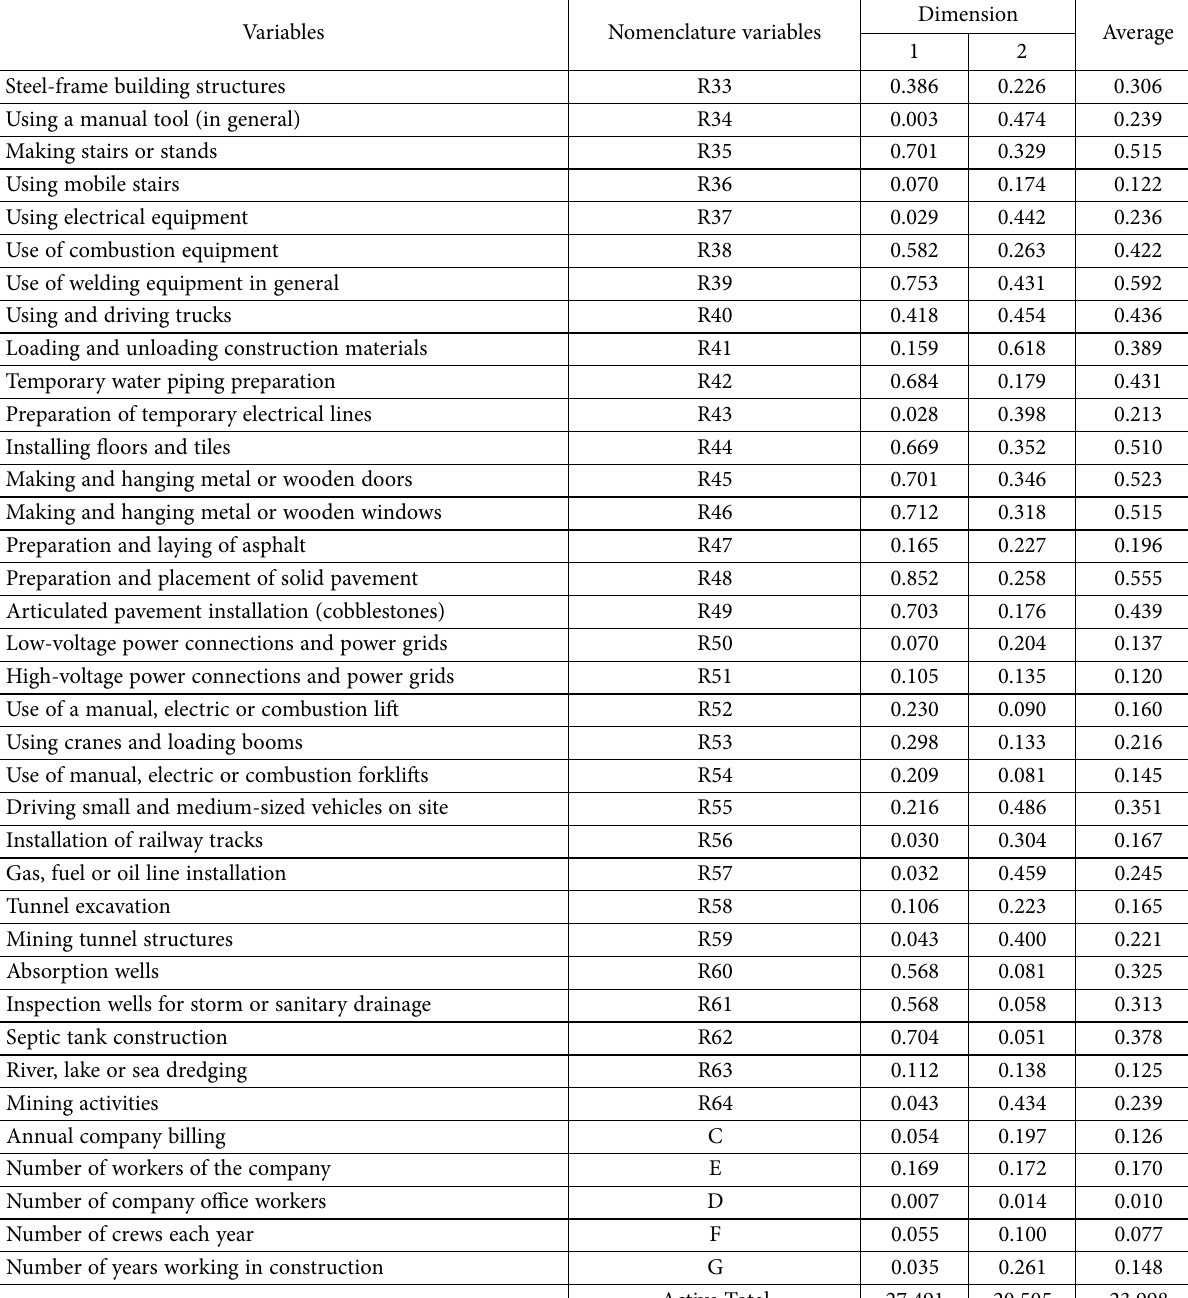
Table 4. Measures of discrimination of the 64 risk-weighting variables for each construction activity and the general company variables for each dimension (Part 2)